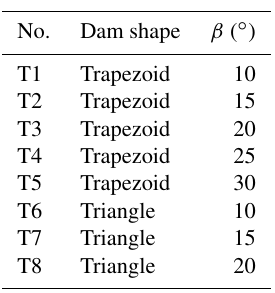
Table 1. Test parameters.